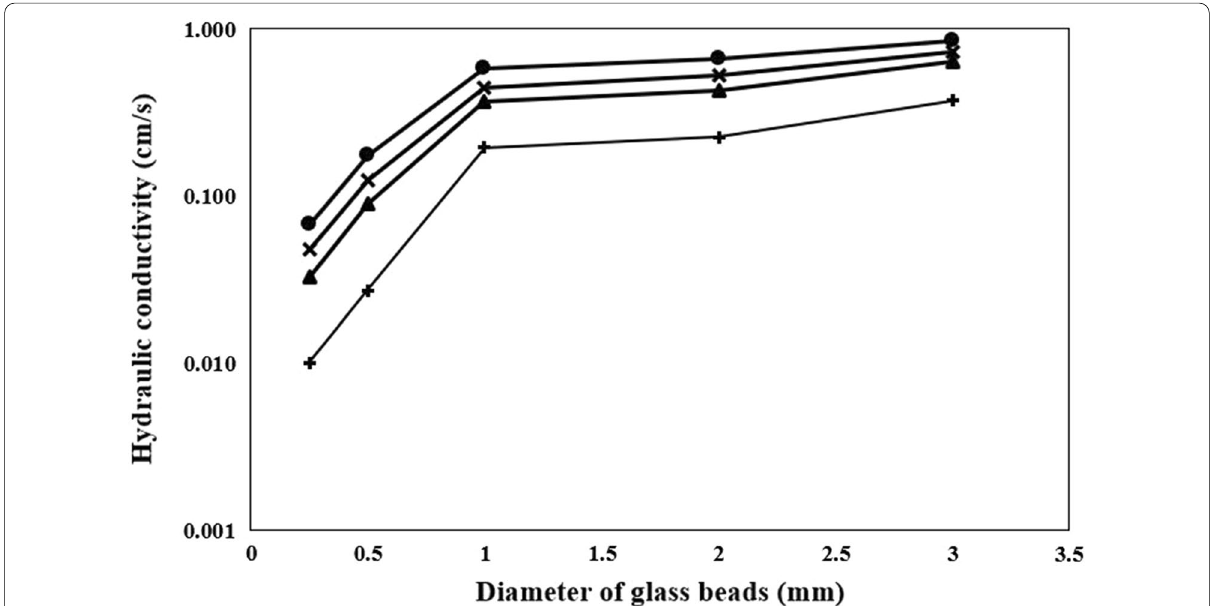
Fig. 2 Hydraulic conductivities of glass beads before treatment (closed circle) and after treatment using 500 mM of CaCl 2 and 500 mM urea, and cell suspension as OD 600 0.15 (cross sign), OD 600 0.75 (closed triangle), OD 600 2.25 (plus